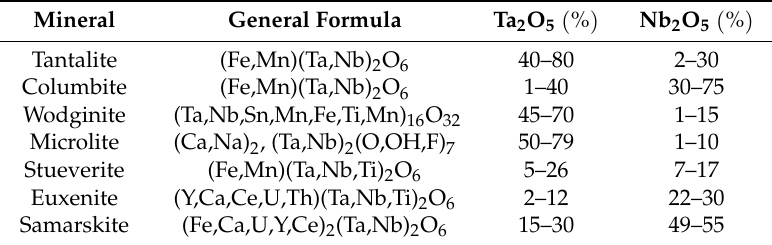
Table 1. Main economic minerals for Ta, data from